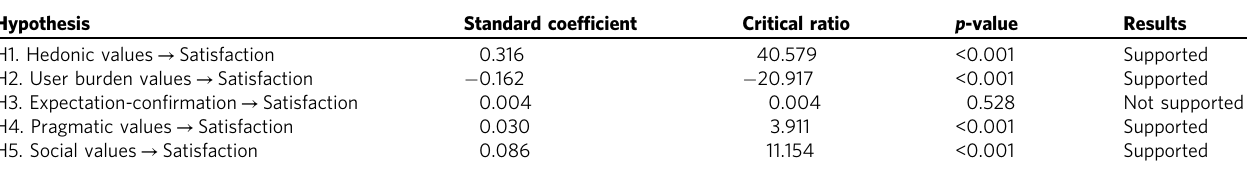
Table 2 Summary of the results for non-gami fi ed fi tness